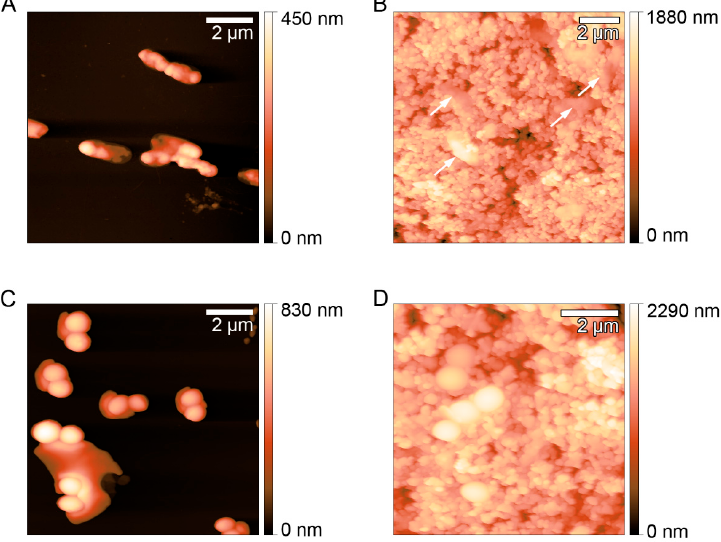
Figure 4. AFM images of P. aeruginosa ATCC 27853 ( A , B ) and of S. aureus ATCC 25923 ( C , D ) deposited on non-coated ( A , C ) and AgNSs-coated surfaces ( B , D ) after 24 h. Arrows point to the P. aeruginosa cells, clearly damaged.